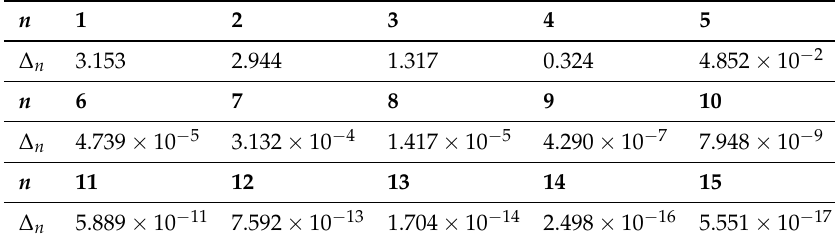
Table 3. Values of errors of the exact solution reconstruction ( ∆ n = (cid:107) y e − (cid:98) u n (cid:107) 1